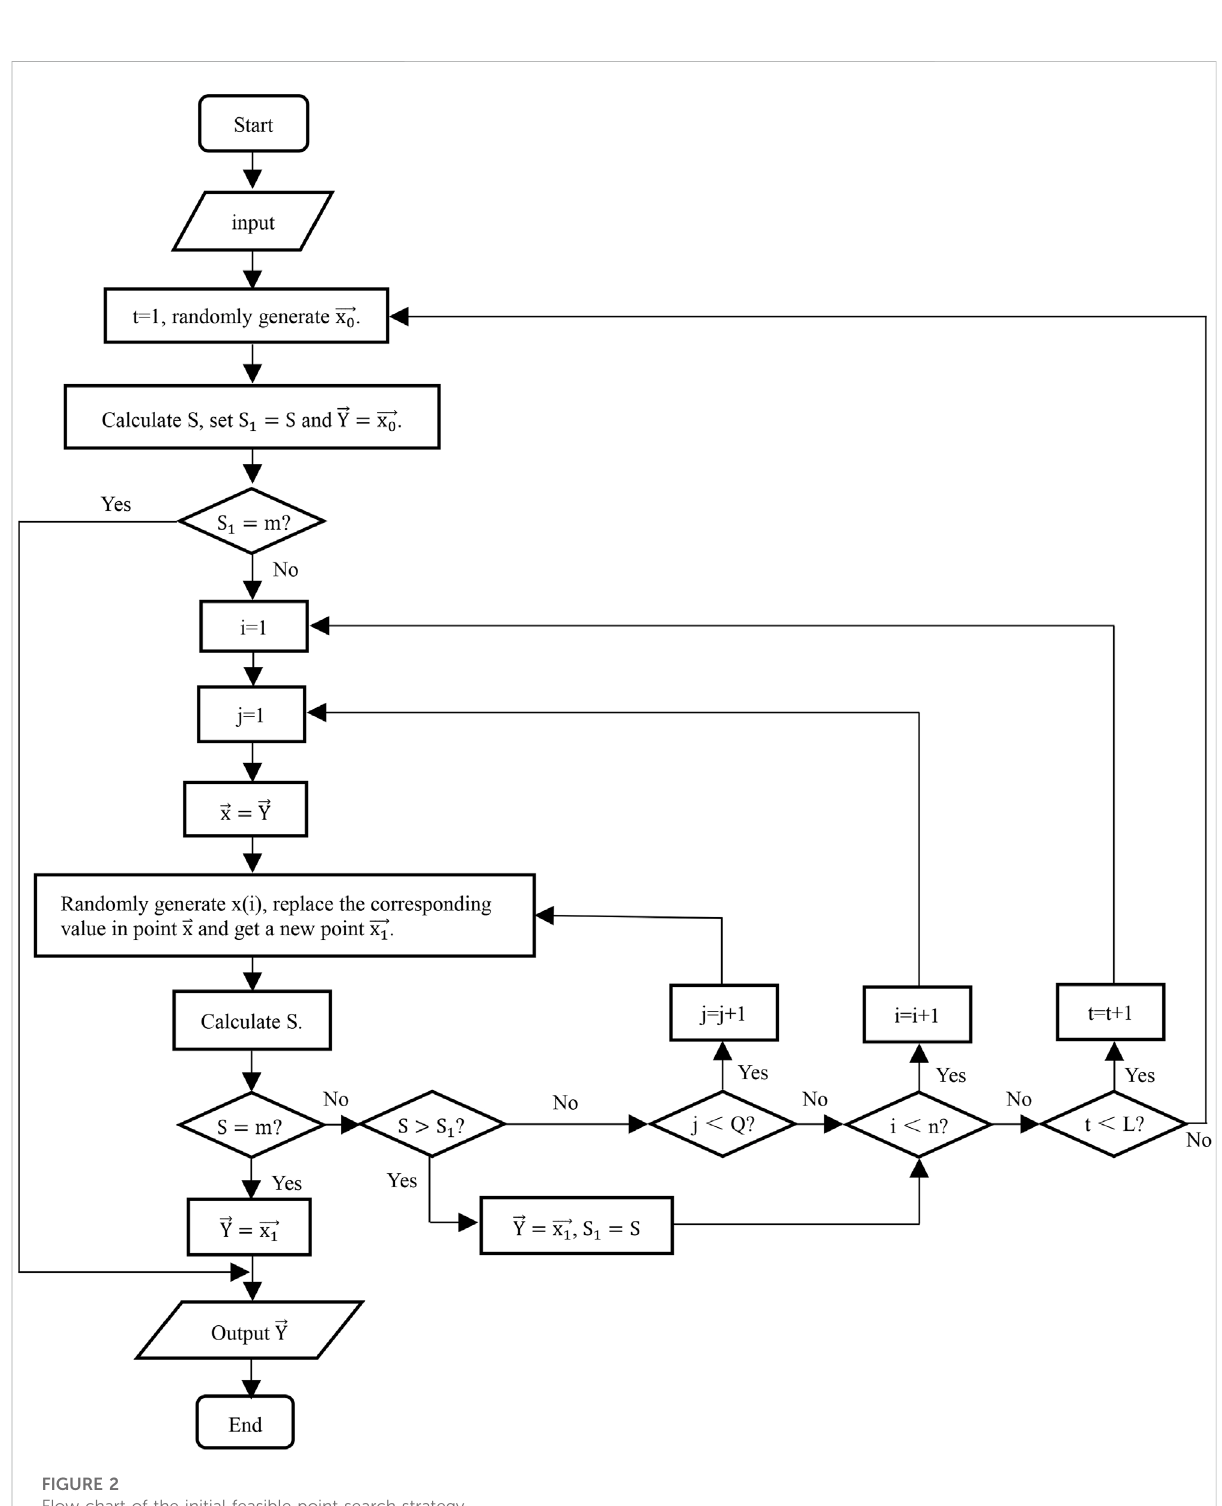
FIGURE 2 Flow chart of the initial feasible point search